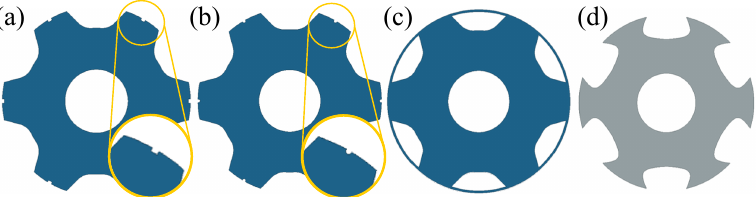
Figure 22. Rotor pole tip modifications: ( a ) rectangular pole surface notch, ( b ) semi-circular pole surface notch, ( c ) rotor rib, and ( d ) curved rotor poles.